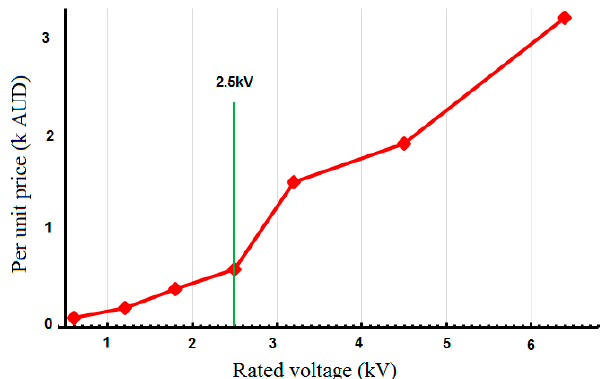
Figure 3. Market price of insulated gate bipolar transistors (IGBTs) [49].